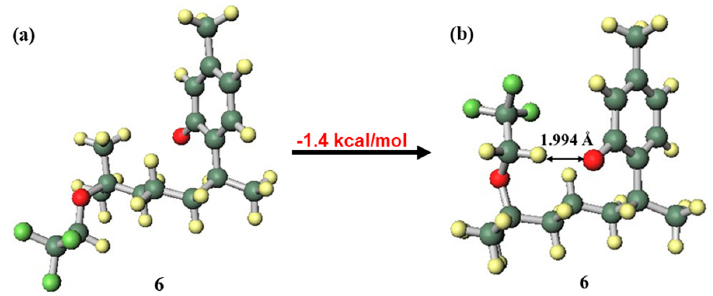
Figure 8. Difference in conformation stability of the compound 6 anion: ( a ) far conformation, ( b ) close conformation.